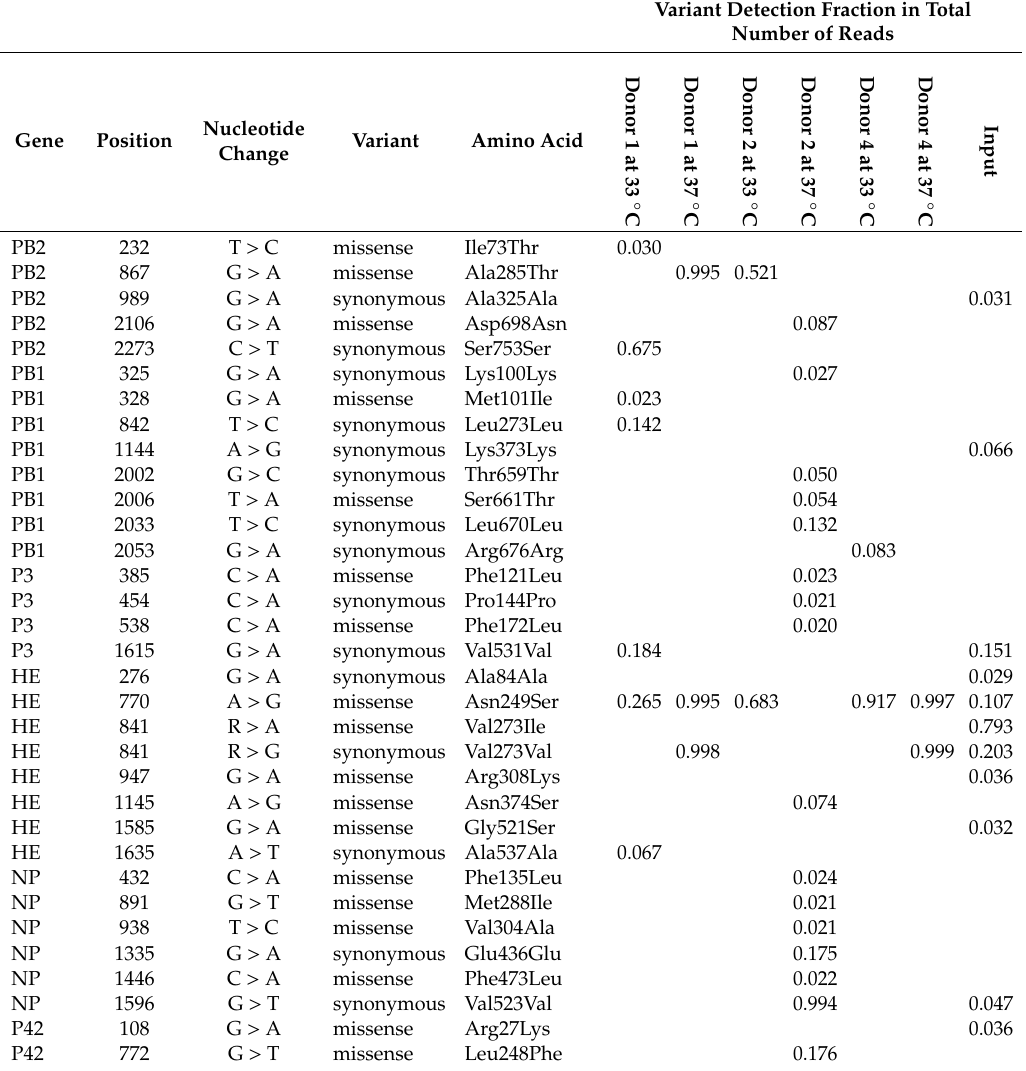
Table 2. Summary of the detected nucleotide variants in serial-passaged IDV on hAEC culturs.